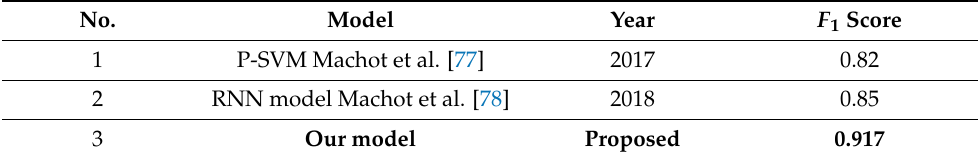
Table 10. Non-fair Comparing Present Model with Existing